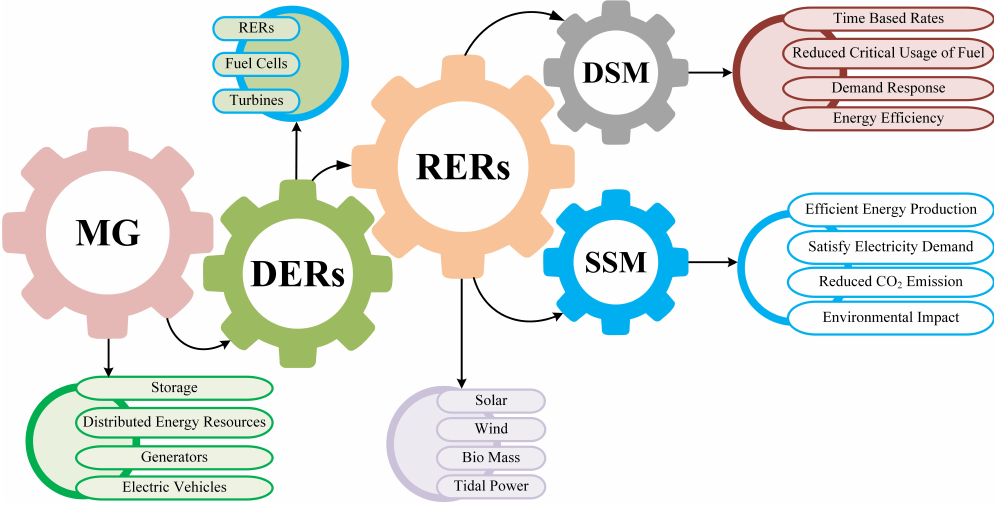
Figure 1. Conceptual approach of